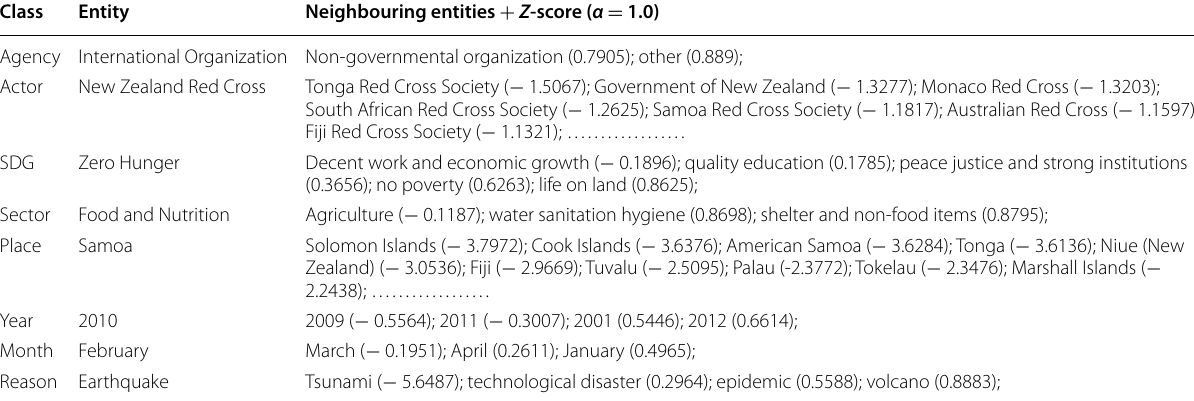
Table 4 Neighbouring entities retrieved in entity retrieval task Class Entity Neighbouring entities